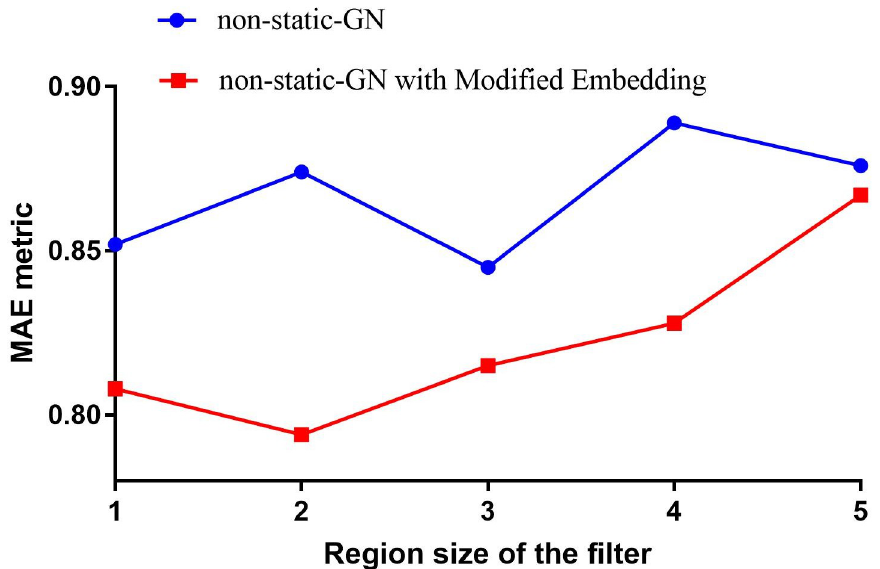
Fig 10. Performance comparison of dynamic GN with different embedding